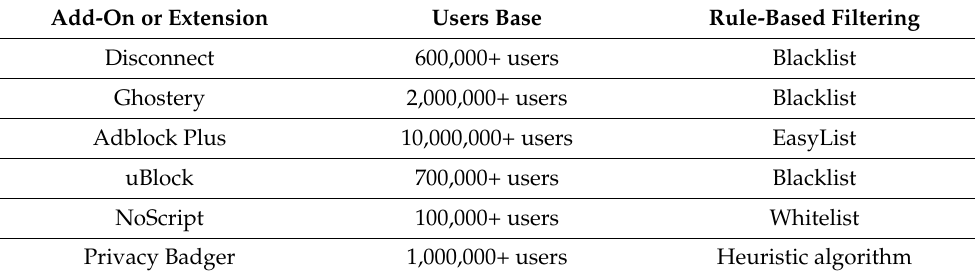
Table 1. Filtering rules and statistics of the Privacy protection